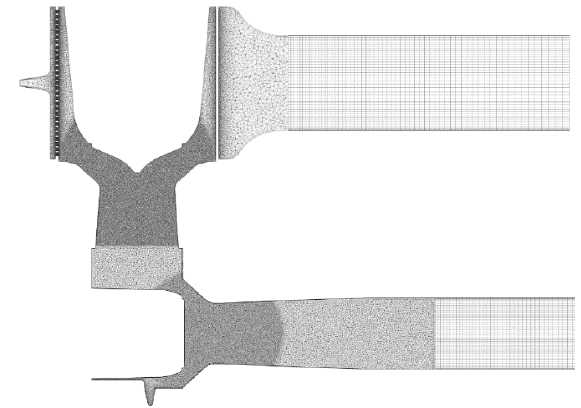
Fig. 6. Mesh in the cross-section through the model [12] .